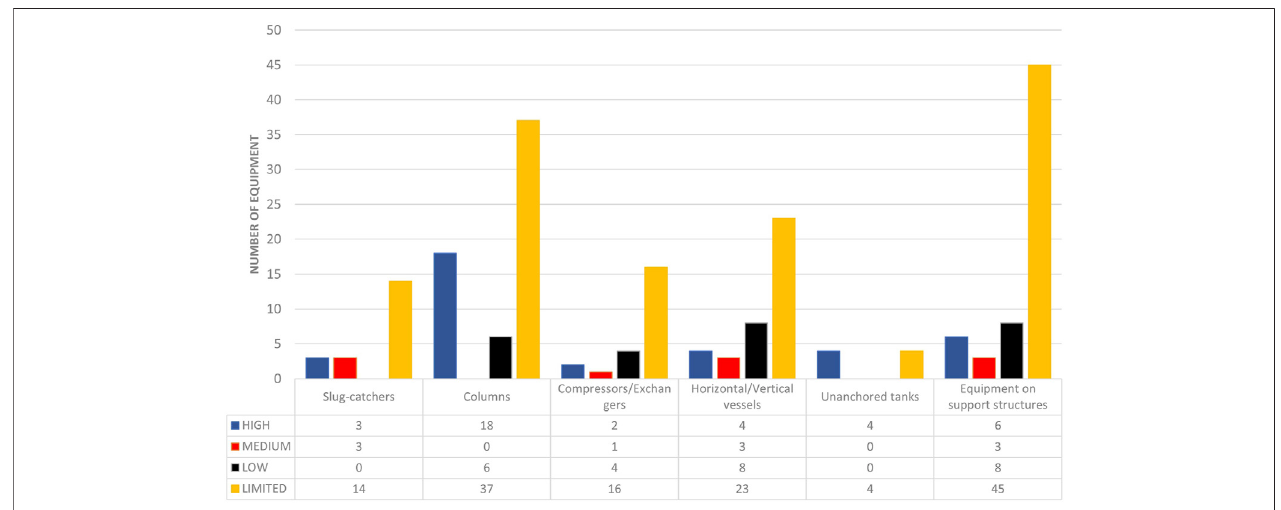
FIGURE 8 | Risk Index I R for the several types of equipment of the plant.